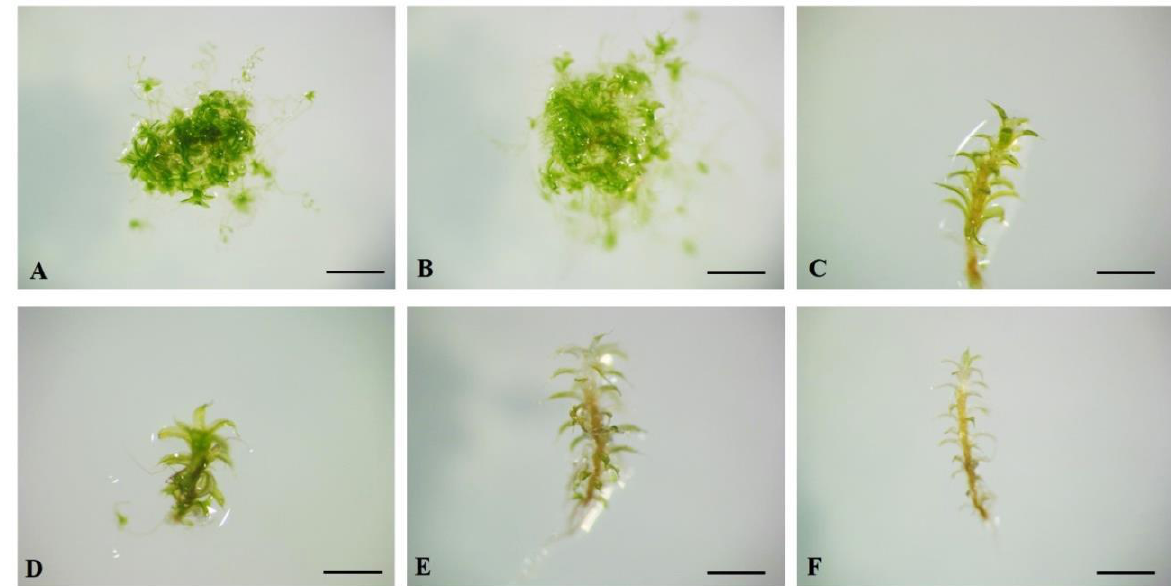
Figure 6. The appearance of Pterygoneurum sibiricum explants grown on KNOP nutrient medium supplemented with different NaCl concentrations: ( A ) control; ( B ) 10 mM NaCl; ( C ) 50 mM NaCl; ( D ) 100 mM NaCl; ( E ) 250 mM NaCl; ( F ) 500 mM NaCl. The bars represent size (( A – F ) 4 mm).